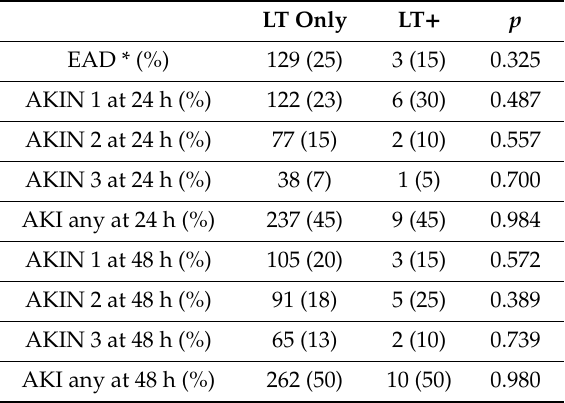
Table 3. Early allograft dysfunction and acute kidney injury outcomes.